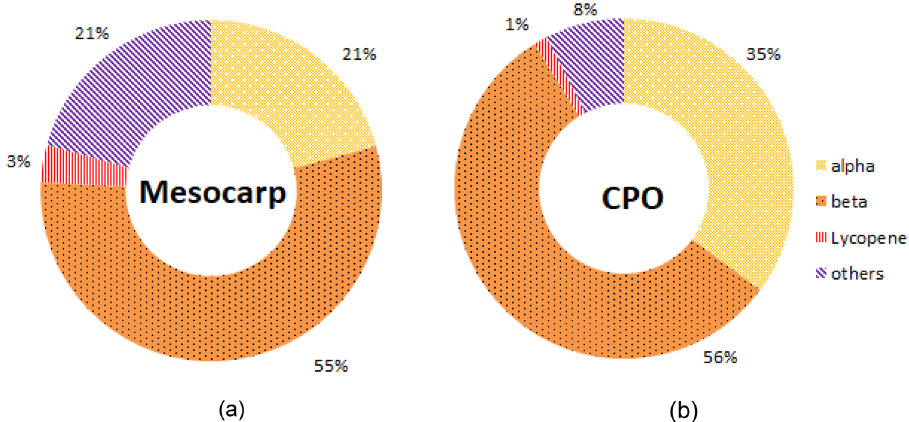
Figure 3. Carotenoid composition (%) of ripe fruit Tenera variety ( a ) Mesocarp extract 48 , ( b ) Crude palm oil 50